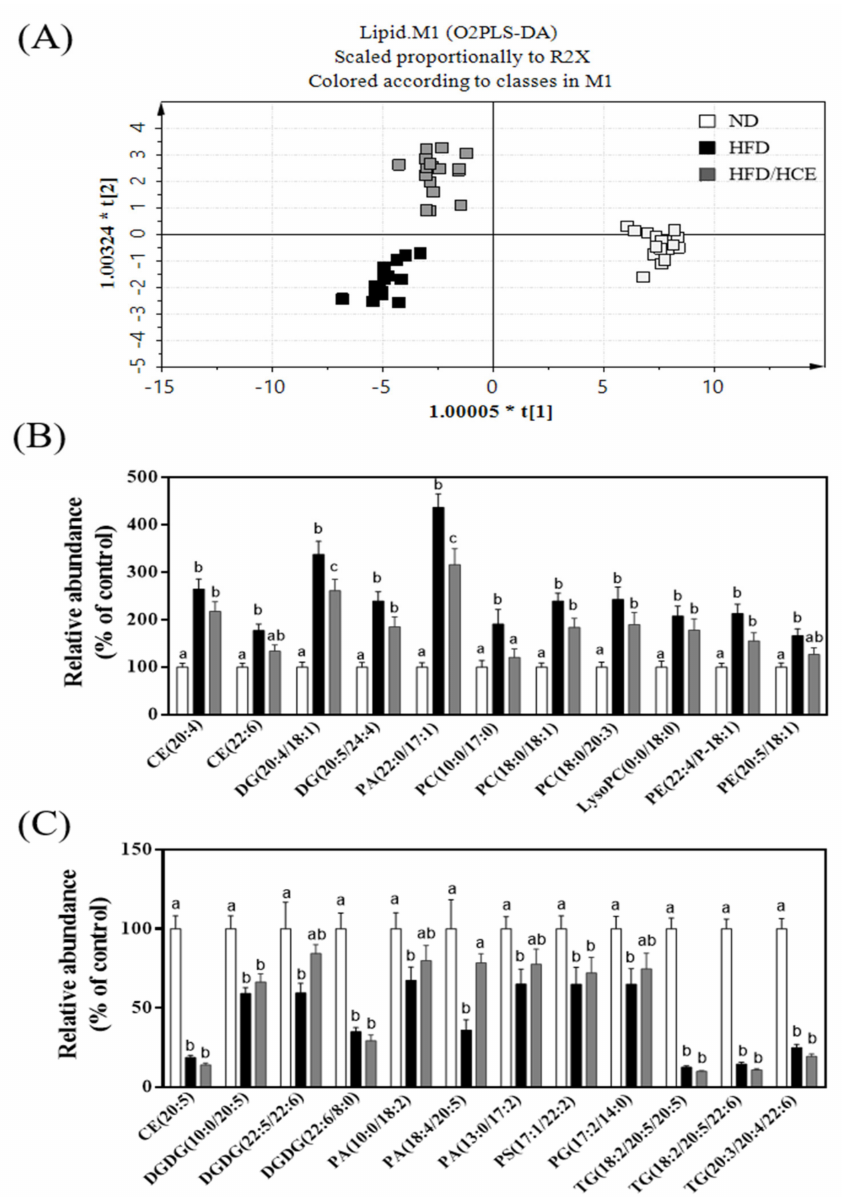
Figure 4. Effect of Djulis hull crude extract on lipidomics in HFD-induced obese mice. ( A ) The orthogonal partial least-squared discriminant analysis (OPLS-DA) score plot for ND, HFD and HFD/HCE groups. The x-and y-axes of OPLS-DA showed the variance explained among the groups. ( B ) Compared with the ND group, the lipid species increased in the HFD group. ( C ) Compared with the ND group, the lipid species decreased in the HFD group. ND: normal diet; HFD: high-fat diet; HCE: high dosage of crude extract. Values represent the mean ± SEM (n = 6). Statistical methods were used by two-way ANOVA, and the different letters are significantly different at p <